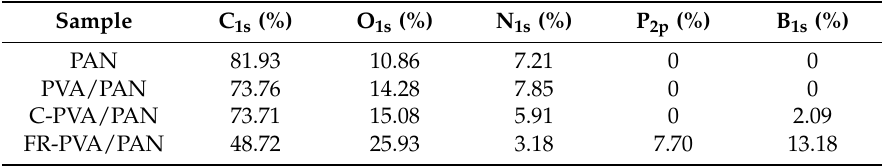
Table 2. Chemical compositions of different fibers.